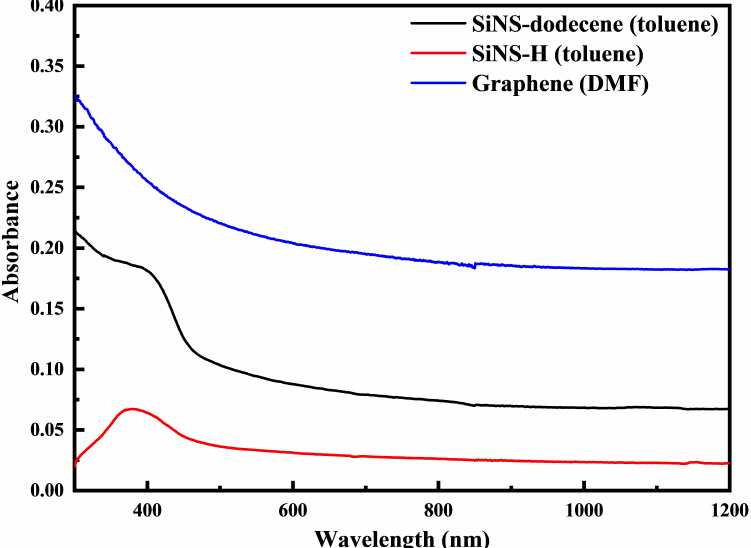
Figure 2. UV-Vis-NIR absorption spectra of SiNS–H and SiNS–dodecene toluene dispersions and a graphene dispersion in DMF. All spectra correspond to a concentration of 0.1